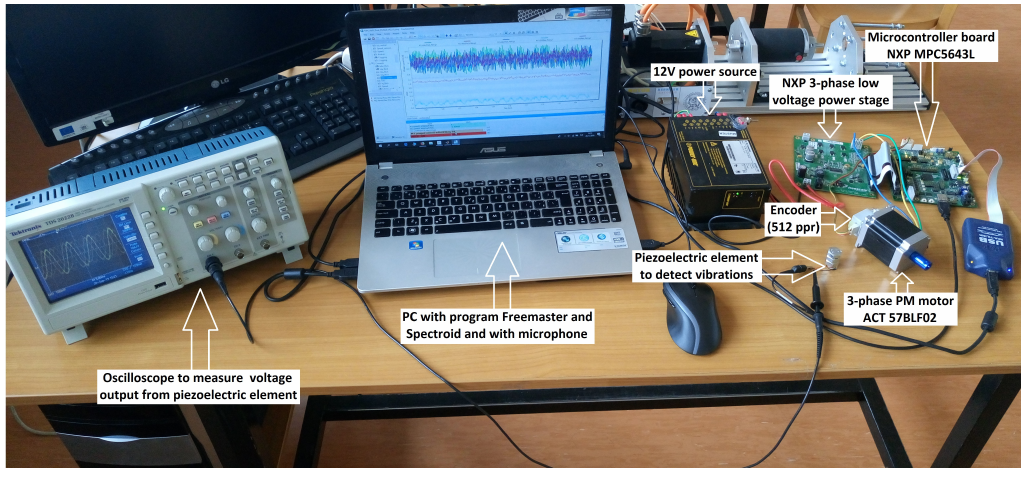
Figure 6. Used experimental setup.